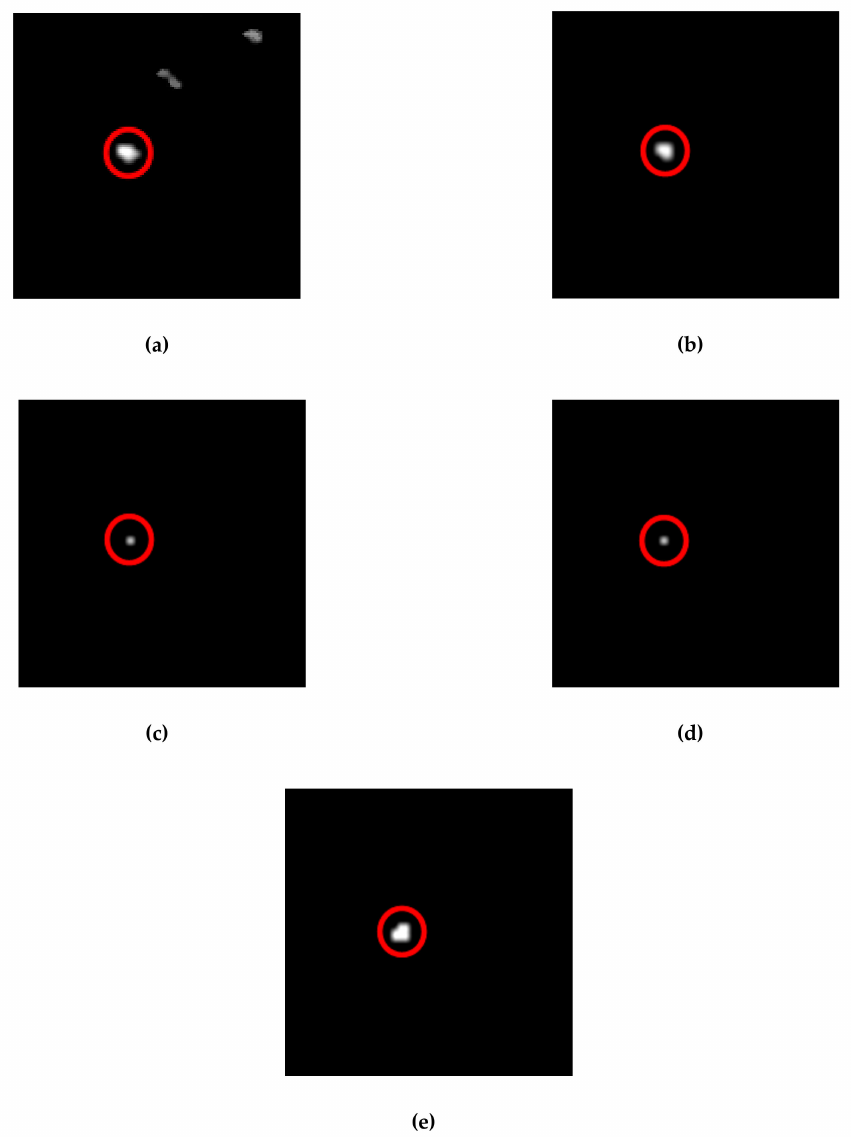
Figure 11. The obtained photovoltaic panel abundance fraction and classification maps for the real sub-image 2: ( a ) Grd-Part-NMF, ( b ) Multi-Part-NMF, ( c ) Grd-NMF, ( d ) Multi-NMF and ( e ) one-class-classification-based. Red circles surround photovoltaic